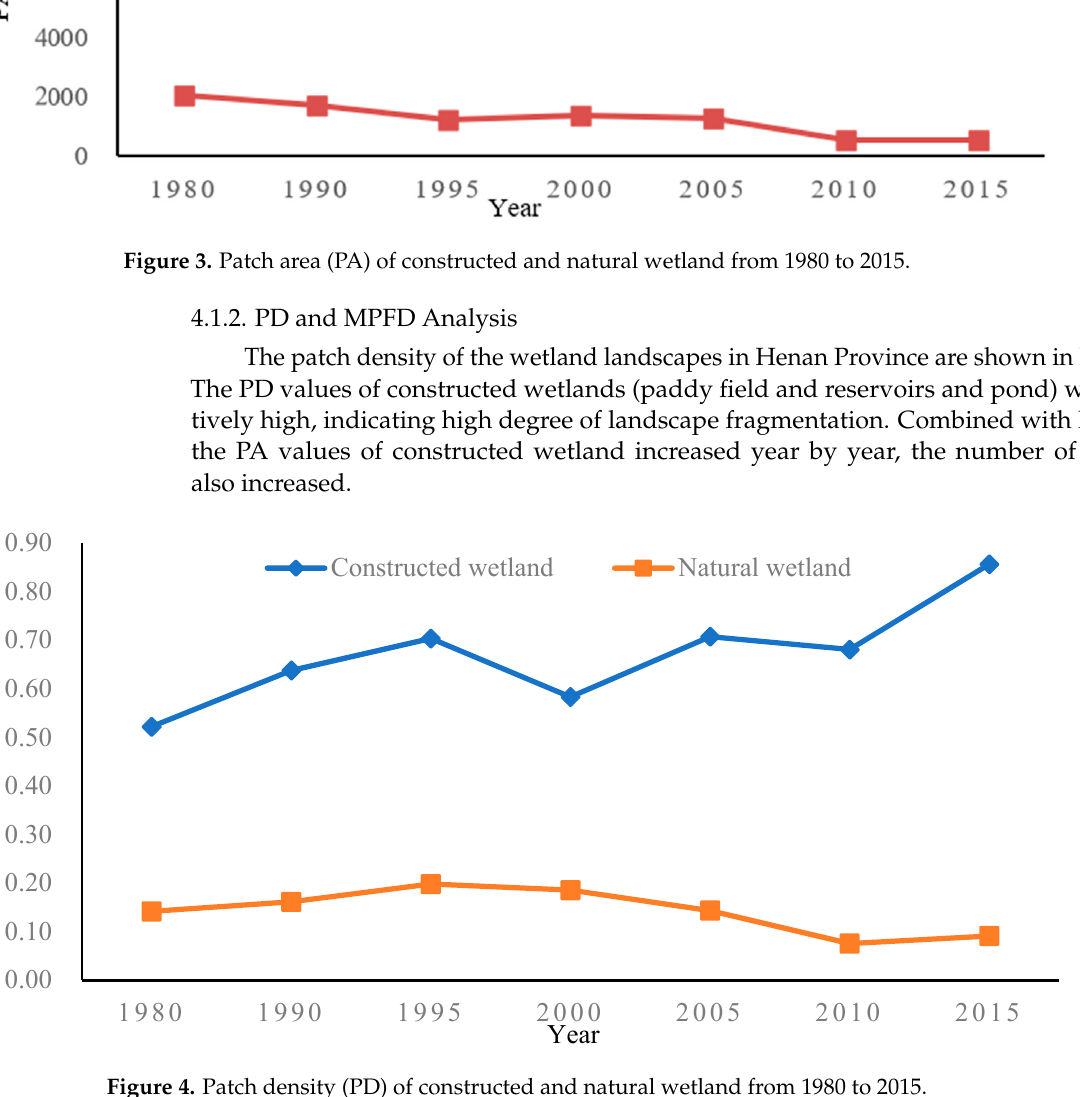
Figure 4. Patch density (PD) of constructed and natural wetland from 1980 to 2015. The mean patch fractal dimension (MPFD) reflects the impact of human activities on the landscape pattern (Figure 5). The closer its value is to 1, the greater the effect of human activities have on the landscape. The results indicated that constructed wetlands were significantly impacted by human activities. The one-way ANOVA test indicated that the landscape metrics between constructed wetlands and natural wetlands had significant differences. Therefore, two categories of wetlands were analyzed from different perspectives in Section